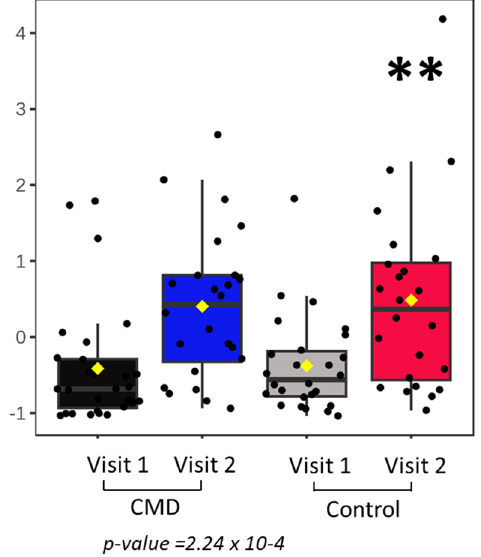
Figure 4. Statistical analysis of patient’s serum. ( a ) Student’s t -tests comparing the total concentration of DHA in serum of Control patients at Visit 1 vs. Visit 2 and CMD patients at Visit 1 vs. Visit 2. Each cohort has significant increases in total DHA. ( b ) The concentration of total DHA was normalized by the weight of extracted lipids and an ANOVA and Tukey’s post hoc analysis was conducted to compare both cohorts at Visits 1 and 2. The CMD group has significant increases in relative DHA at Visit 2 and is significantly higher than all other variables. Asterisks indicate statistical significance with * p value < 0.05 and ** p value < 0.001.